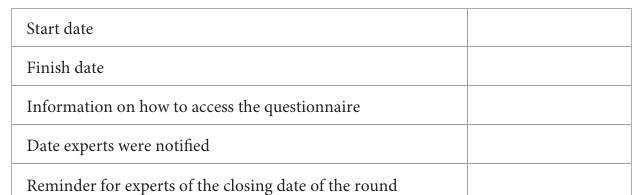
Table 4. • Activity 3: After applying feedback, fill in the “ Has it been done? ” section of Table 4 with Y (yes) or N (no). If N is entered, specify why the recommended actions have not been carried out.